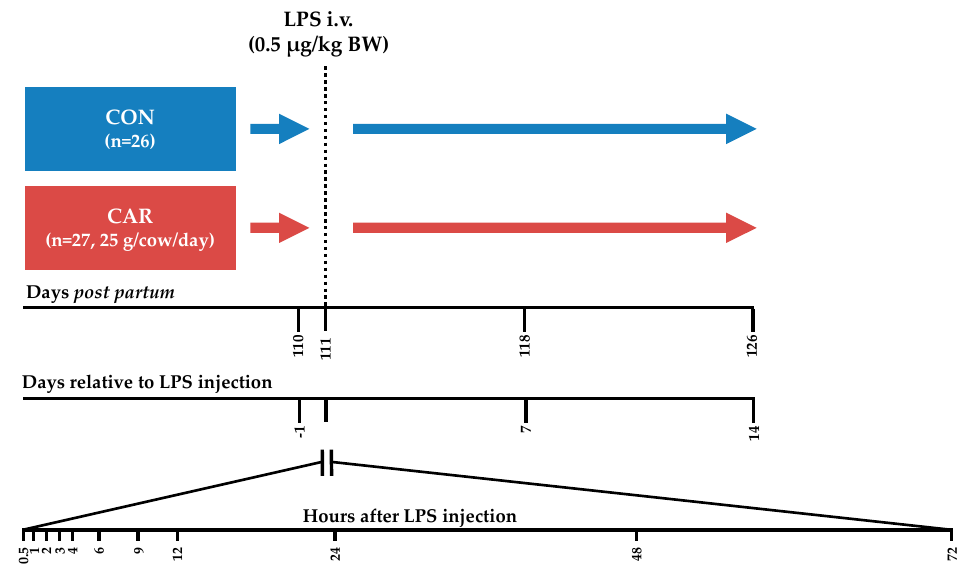
Figure 1. Experimental design. Cows in the control group (CON) as well as cows in the L -carnitine supplemented (CAR) group received an intravenous (i.v.) bolus injection of 0.5 µ g/kg body weight (BW) lipopolysaccharides (LPS) on day 111 post-partum. Blood samples were collected until 14 days after LPS injection and frequently at the presented time points. The components and chemical compositions of roughages and concentrates were previously published by Meyer et al.